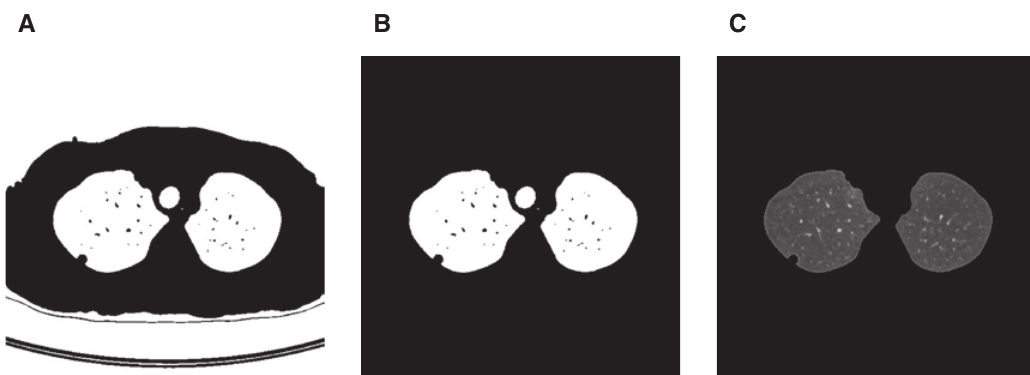
Figure 3: (A) Segmentation Result. (B) 2D Reconstruction. (C) Initial Lung Parenchyma